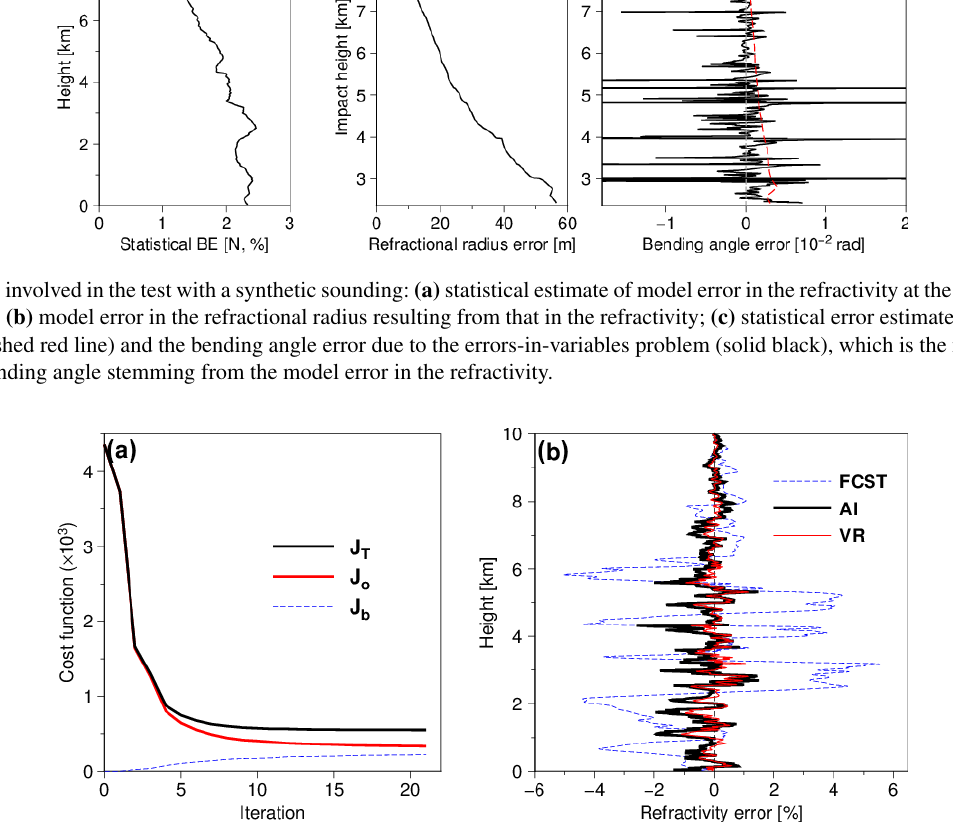
Figure 6. (a) Change of the cost function with iteration in the variational regularization: observational term (denoted J o , thick red line); background term ( J b , dashed blue), and the total cost function (J T = J o + J b , thick black). (b) Refractivity error of the background (dashed blue), of the Abel inversion (thick black), and of the variational regularization